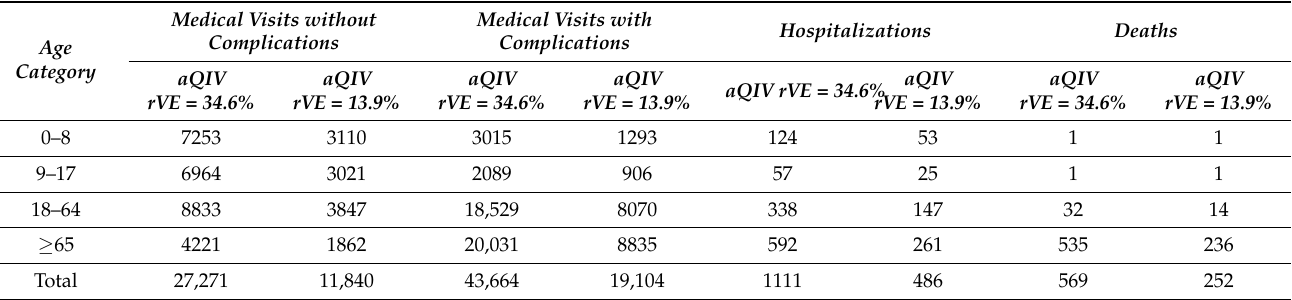
Table 11. Clinical events prevented—aQIV vs. QIVe.